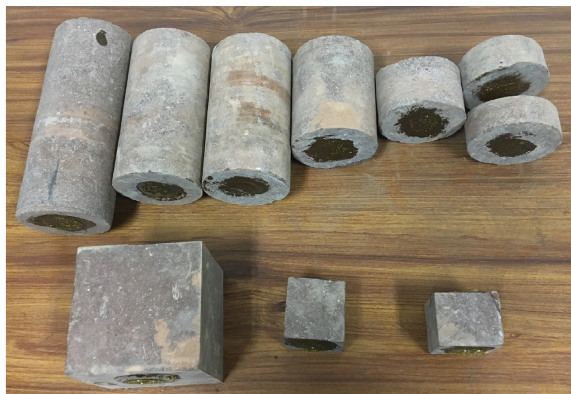
Figure 8: Cores of artificial sandstone adopted in the test.